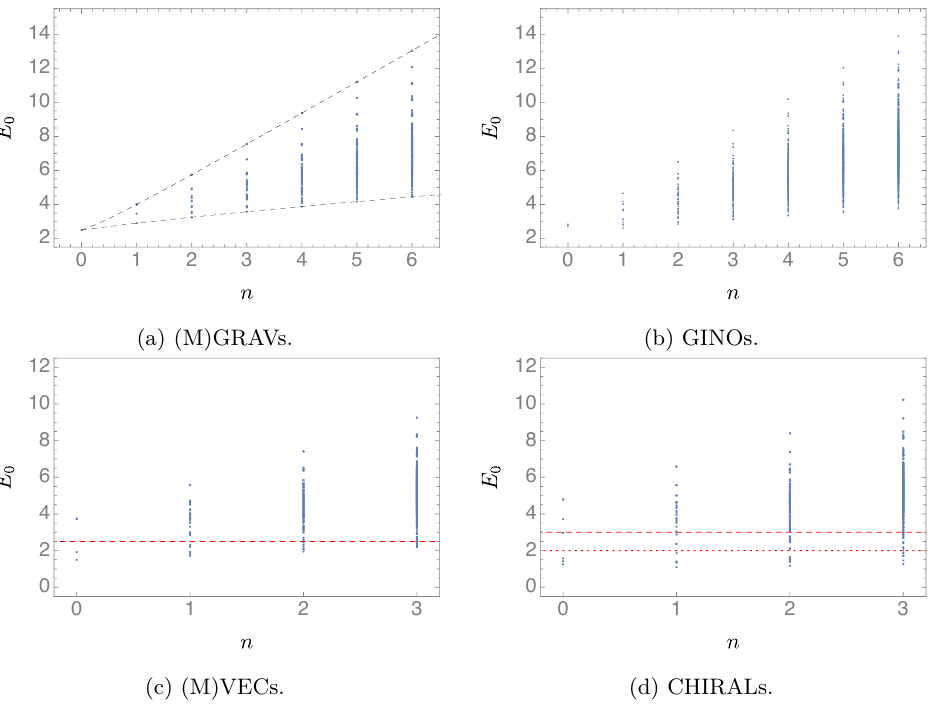
Figure 1 . Dimensions E 0 of all four types of OSp (4 | 1) multiplets present in the spectrum of the D = 11 SO(3)-invariant solution at first few KK levels n